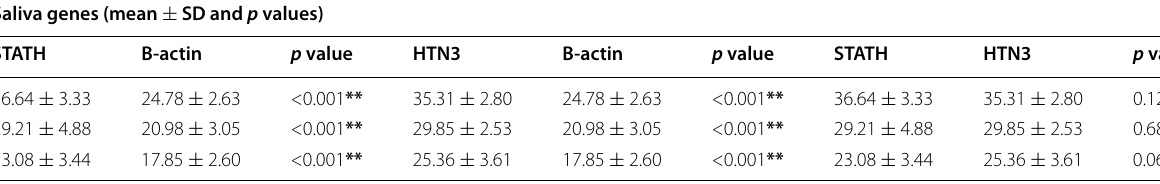
HTN3 Histatin 3, B-actin Beta-actin, STATH Statherin, SD Standard deviation Paired t test (* P is significant if < 0.05, ** P is highly significant if < 0.01)